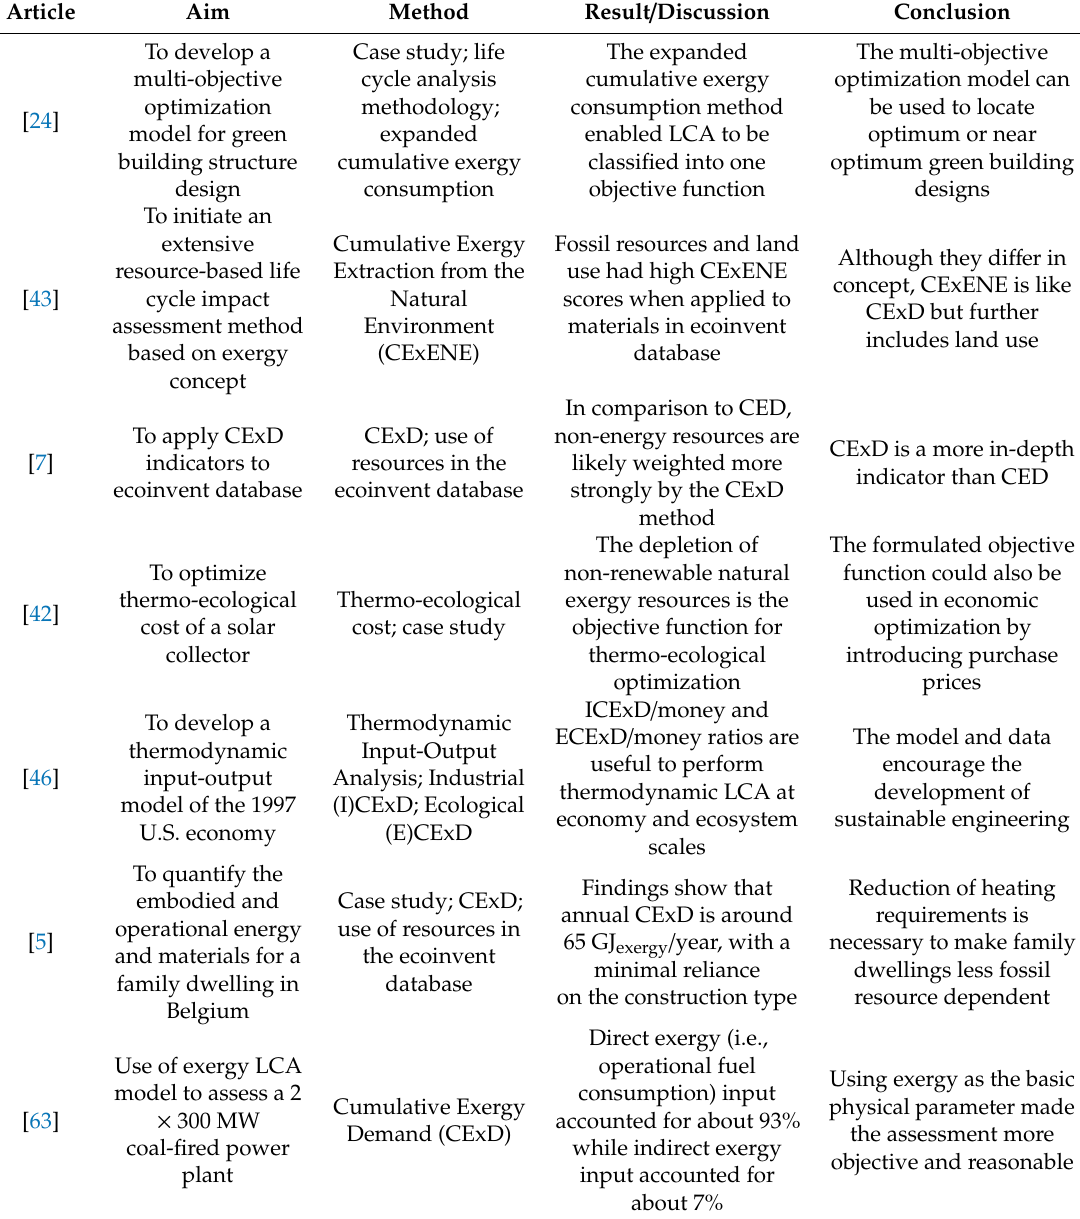
Table 4. Analysis of articles on use of exergy methods in sustainability